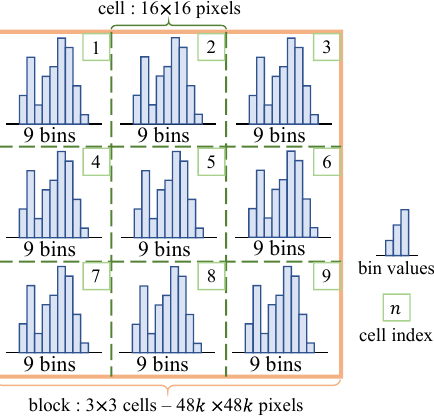
Figure 2. Architecture of blocks and cells in the existing